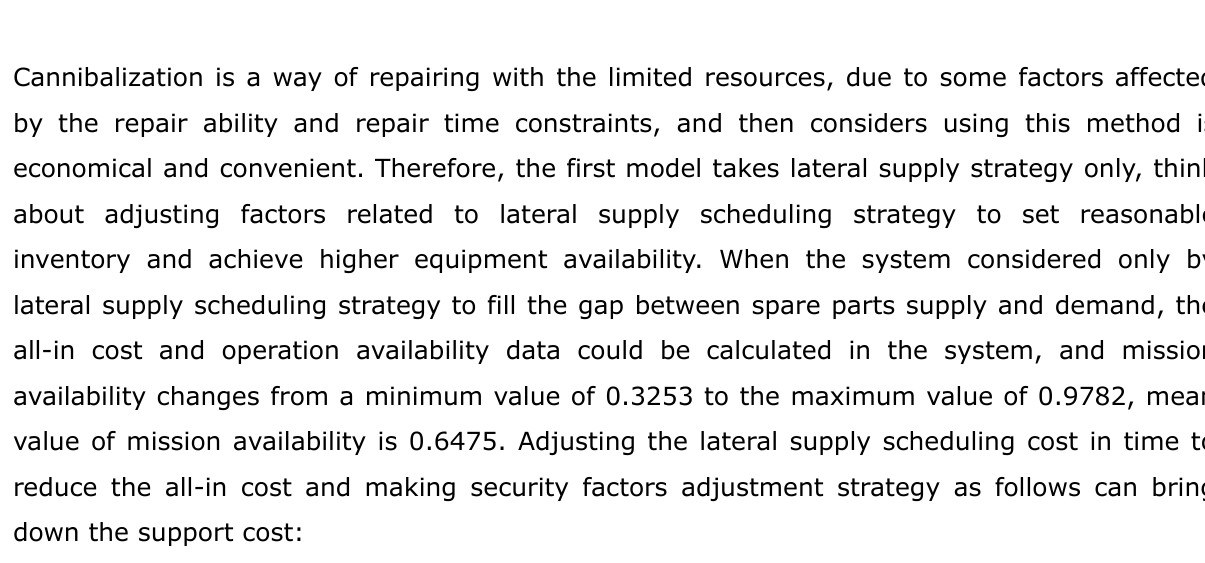
Figure 9. Finised repair rate of repairable spare parts